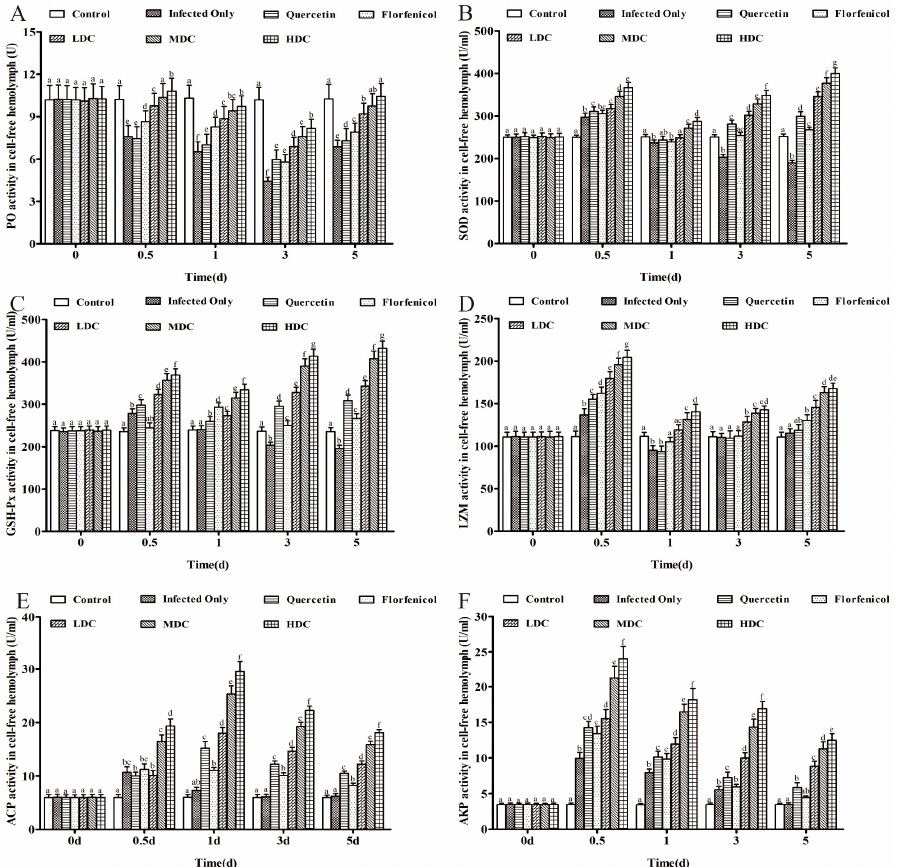
Figure 4. Immunity-related enzyme activities in drug-treated L. vannamei . ( A ) PO, ( B ) SOD, ( C ) GSH-Px, ( D ) LZM, ( E ) ACP, and ( F ) AKP in L. vannamei acellular hemolymph after different times of drug treatment. One-way ANOVA and Duncan’s multiple range test were used to analyze the significant differences among different groups, and different letters represent significant differences between groups ( p < 0.05).